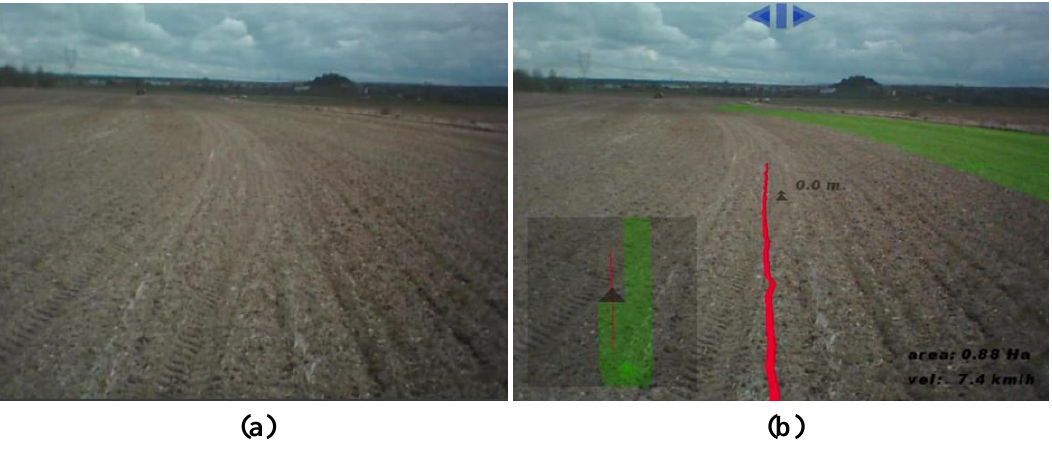
Figure 7. A possible scene that the tractor driver sees: ( a ) without the developed system or ( b ) with the developed augmented reality system.